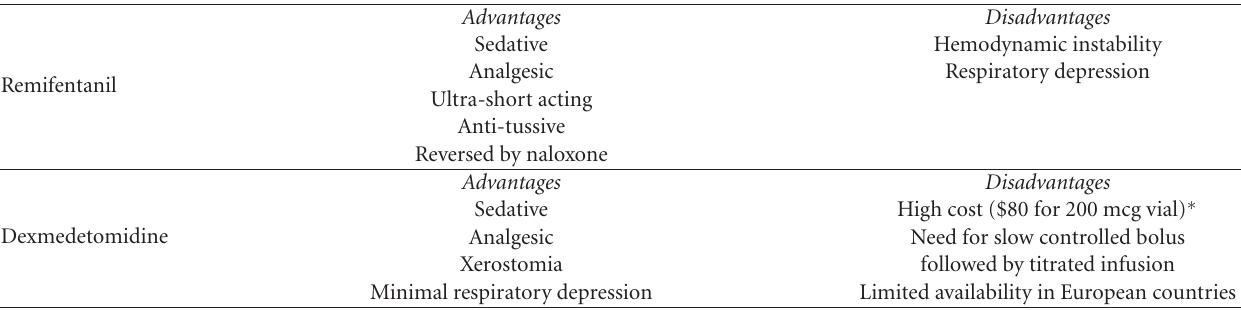
Table 1: Advantages and disadvantages of remifentanil versus dexmedetomidine.